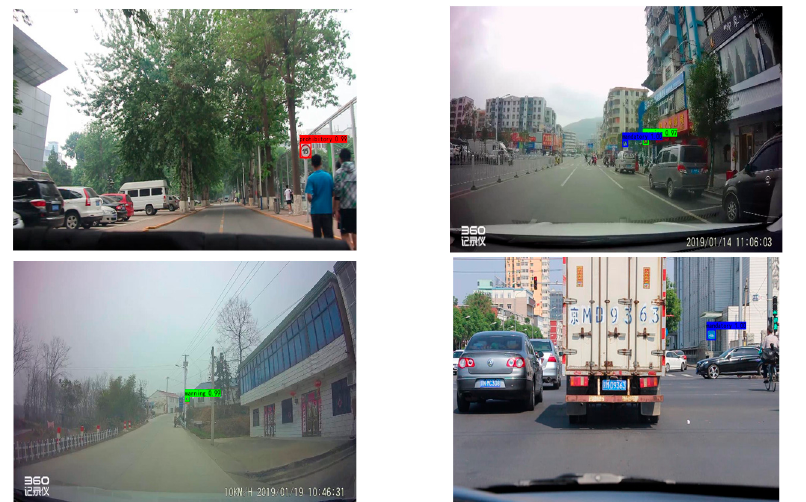
Figure 12. Urban road test results.